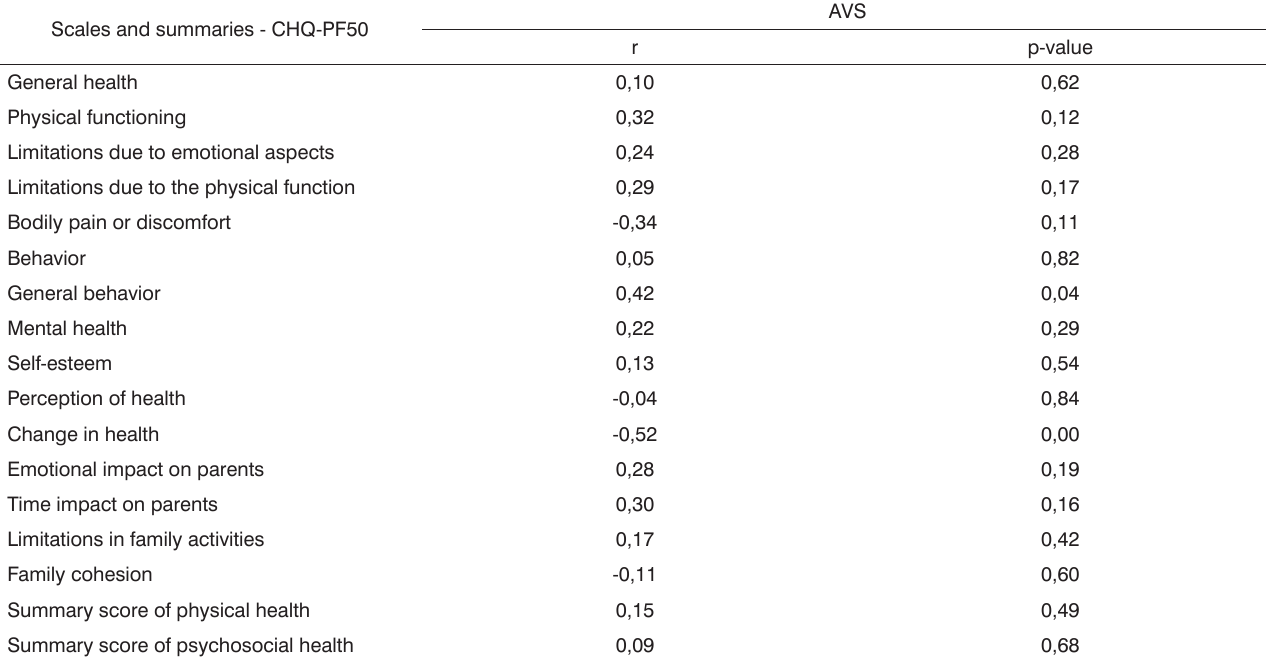
Table 4. Correlation among CHQ-PF50 scores and the analog visual scale